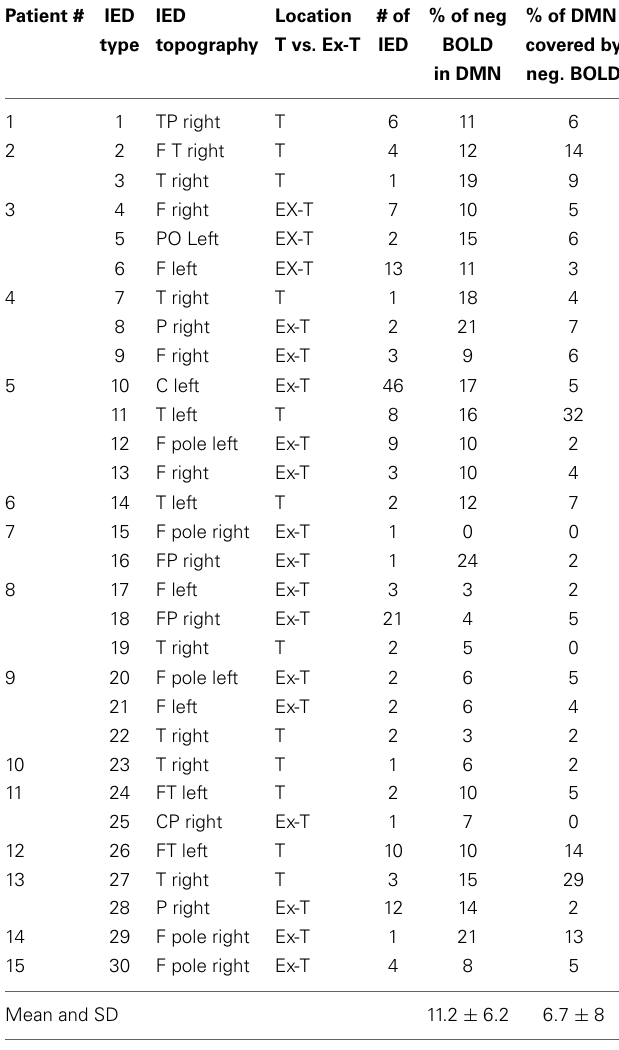
Table 2 | Summary of IED types and overlap between DMN and negative